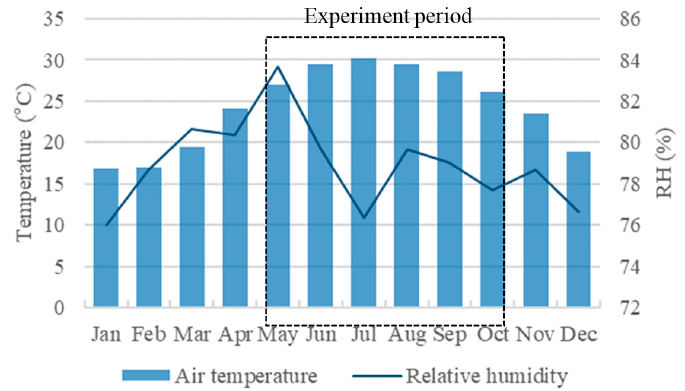
Figure 1. Average temperature and relative humidity observed at the nearest weather station (Long-Jing station), Taichung, 2014–2016.